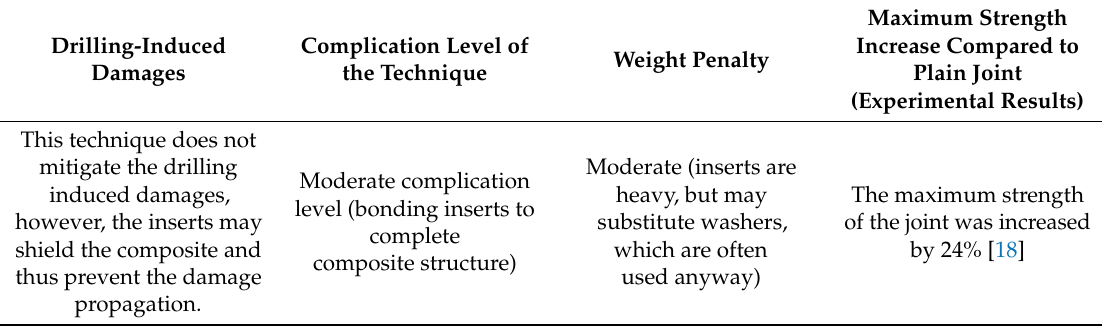
E ff ect of metal bonded inserts on performance of bolted joints is summarized in Table 1. Table 1. Summary of metal bonded inserts e ff ect on performance of bolted joints in composite